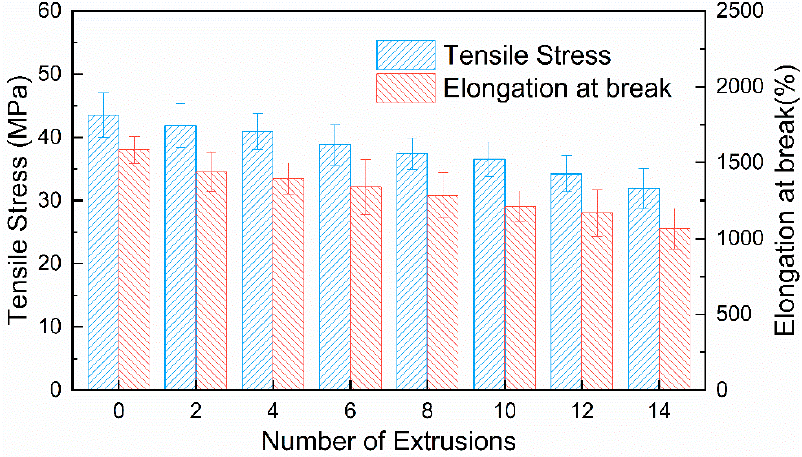
Figure 6. Variations of tensile properties in PP with different numbers of extrusions.